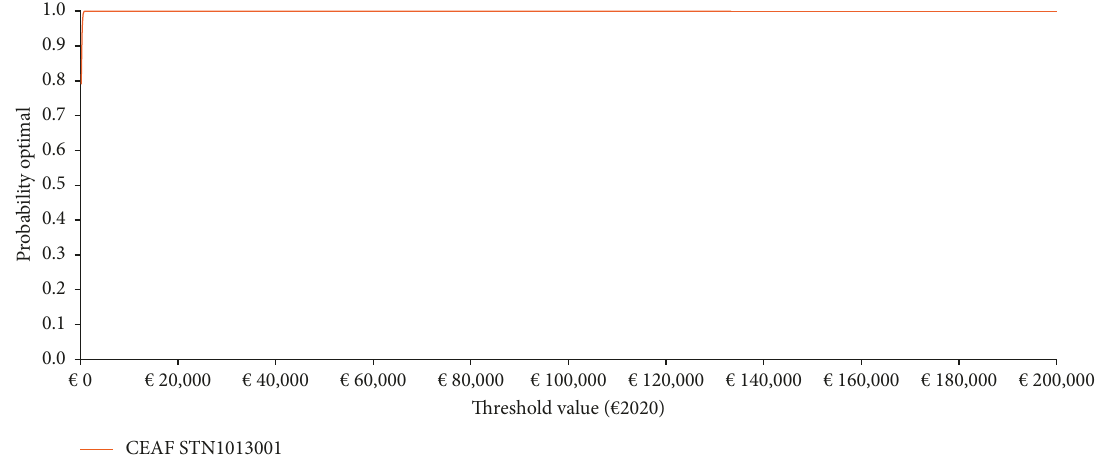
Figure 6: Probabilistic sensitivity analysis-III-cost-effectiveness acceptability frontier (1000 out of 1000 threshold values reported) (